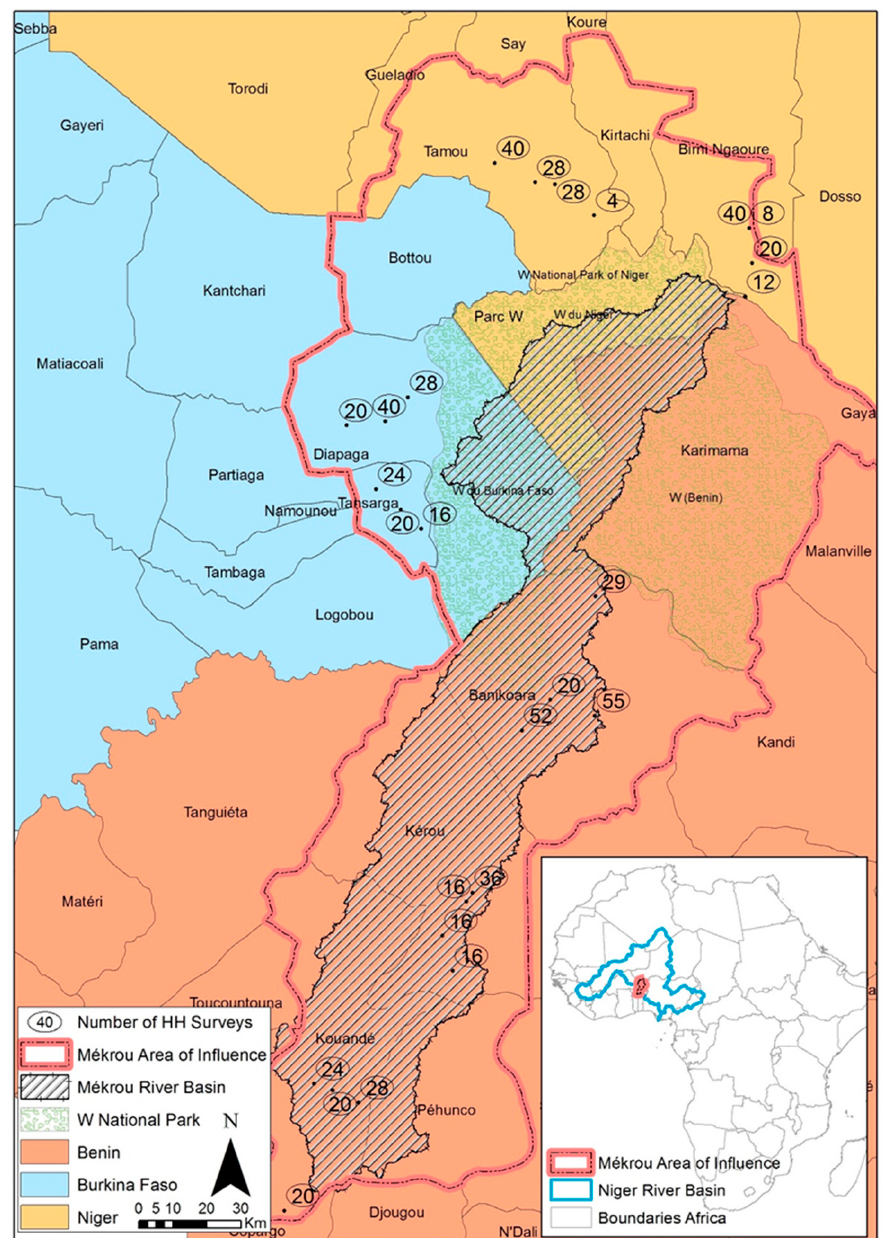
Figure 1. The M é krou river basin and the household survey Figure 1. The Mékrou river basin and the household survey area.